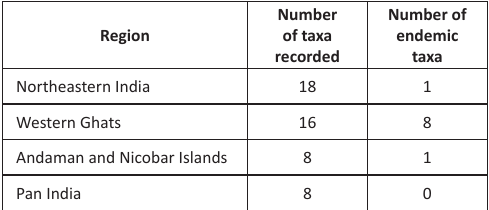
Table 1. Distribution pattern of Elaeocarpus species in India Region Northeastern India 18 1 Western Ghats 16 Andaman and Nicobar Islands